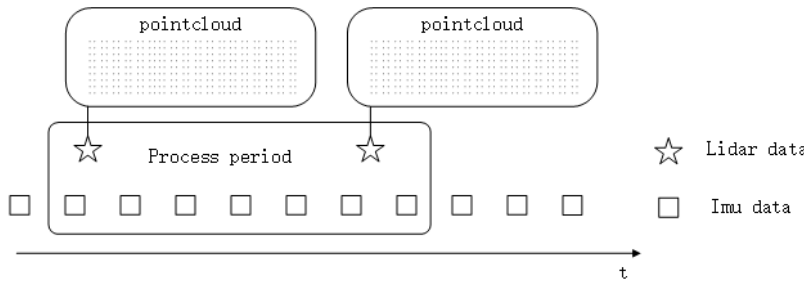
Figure 4. Sensor data in a processing period.